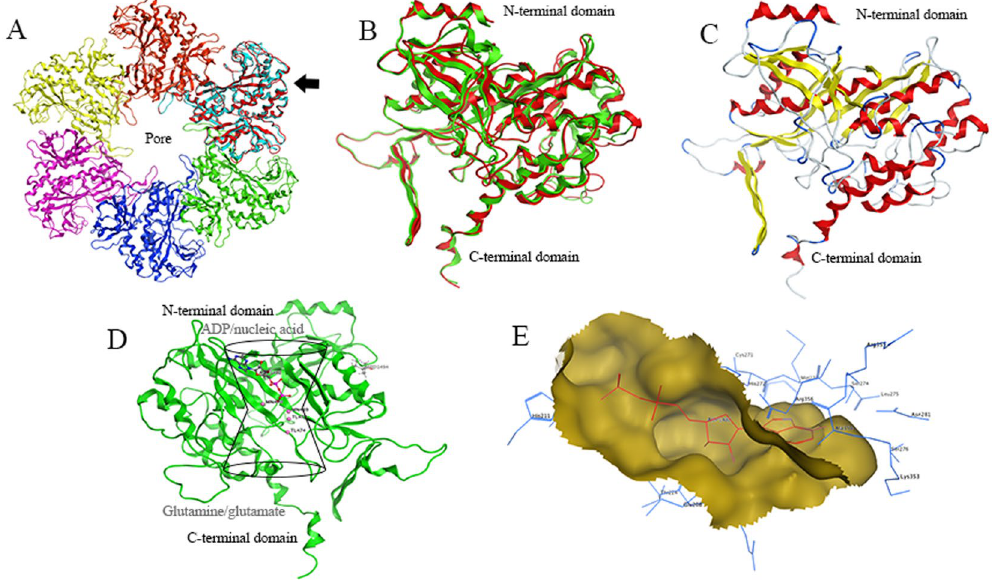
Figure 2. Pve GS model and ADP docking analysis. ( A ) Hexamer ring of S . typhimurium GS, the black arrow pointed to the superimposition of Pve GS and S. typhimurium GS monomer (cyan). ( B ) The detailed superimposition between the model of Pve GS and the S. typhimurium (green), the N terminus and C terminus domains were labelled. ( C ) The Pve GS homology model, with α -helices in red, and β -strands in yellow. ( D ) The interaction analysis between ADP, Tl + , Mn 2 + and Pve GS; the schematic diagram of bifunnel structure and its substrate: nucleotide, ammonium ion, and amino acid, were noted. ( E ) The interaction surface and amino acids residues of ADP and Pve GS